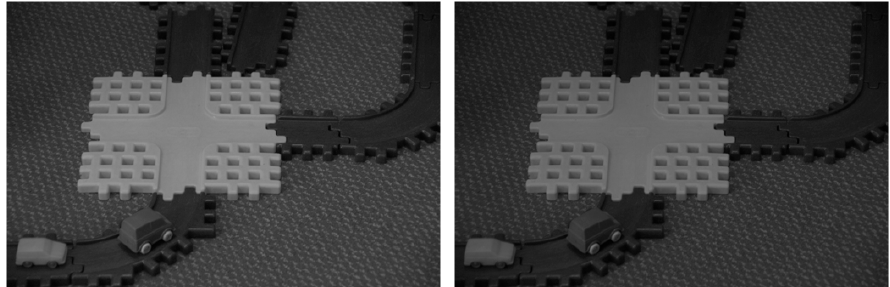
Figure 1. Two sample images; the left image is the reference image whereas the right image undergoes 20% uniform decrease in illumination.